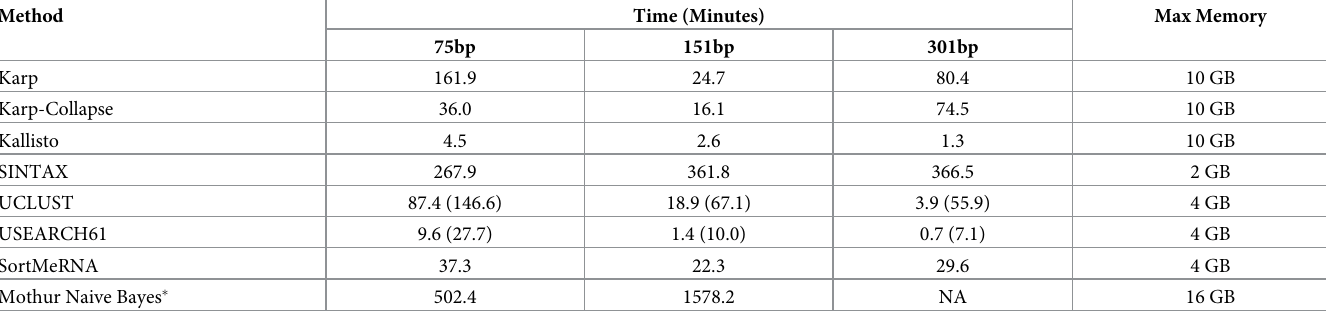
the methods while classifying samples with either 10 6 75bp single-end, 151bp paired-end, or 301bp paired-end reads using 12 cores, and in all cases even the full mode of Karp requires < 3 hours. Karp was run with default settings, in both full and collapse mode. For Karp and Kal- listo the 75bp reads require longer to classify than the 151bp reads due to the larger number of multiply-mapped reads resulting from the shorter length. Table 3. Computational requirements and speed of Karp, Kallisto, SINTAX, UCLUST, USEARCH61, SortMeRNA, and the Wang et al. (2007) Naive Bayes using Mothur. All programs were run using 12 multi-threaded cores except Mothur. Mothur’s memory requirements scale with the number of cores used, and in order to keep memory < 16GB we limited it to 4 cores. The values for UCLUST and USEARCH give the time to assign taxonomy, generally with these methods reads are clustered before taxonomy is assigned and the value in parenthesis gives the time to first cluster and then assign taxonomy. The results for the method 16S Classifier are not shown: it was fast and required a few minutes at most; however its memory usage scaled dramatically with the number of reads. To keep memory usage < 128GB samples needed to be split into several smaller samples and then reassembled. Additionally, it could not be run in parallel, so a meaningful comparison against the other methods of speed and memory requirements was not